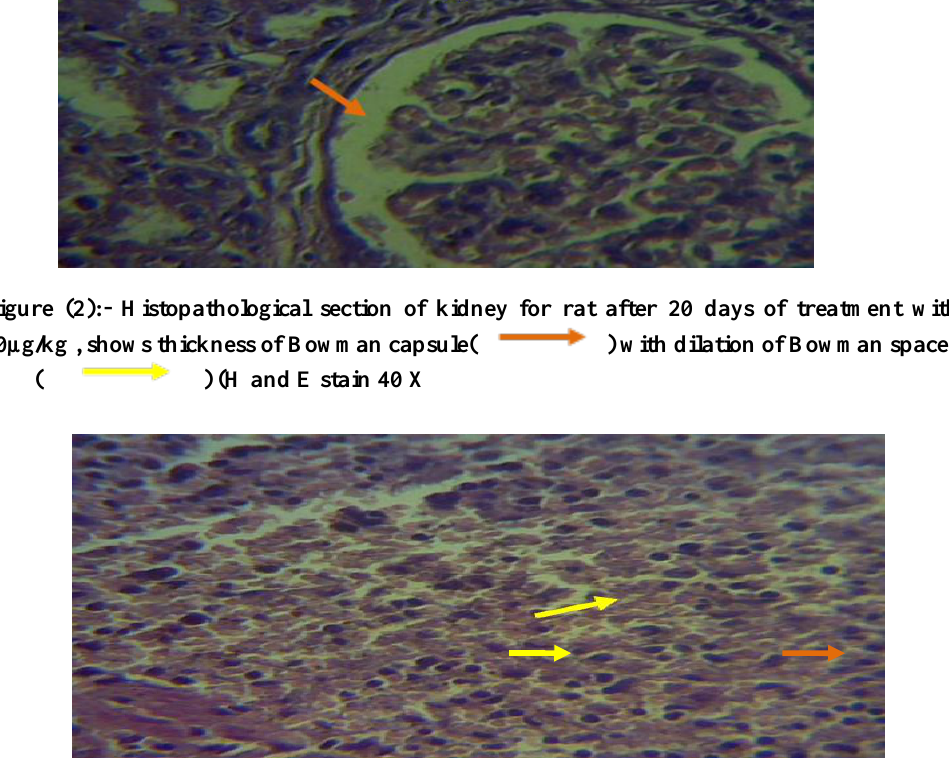
Figure (3):- Histopathological section of spleen for rat after 20 days of treatment with OTA at dose 70µg/kg show congestion of red pulps and blood vessels (